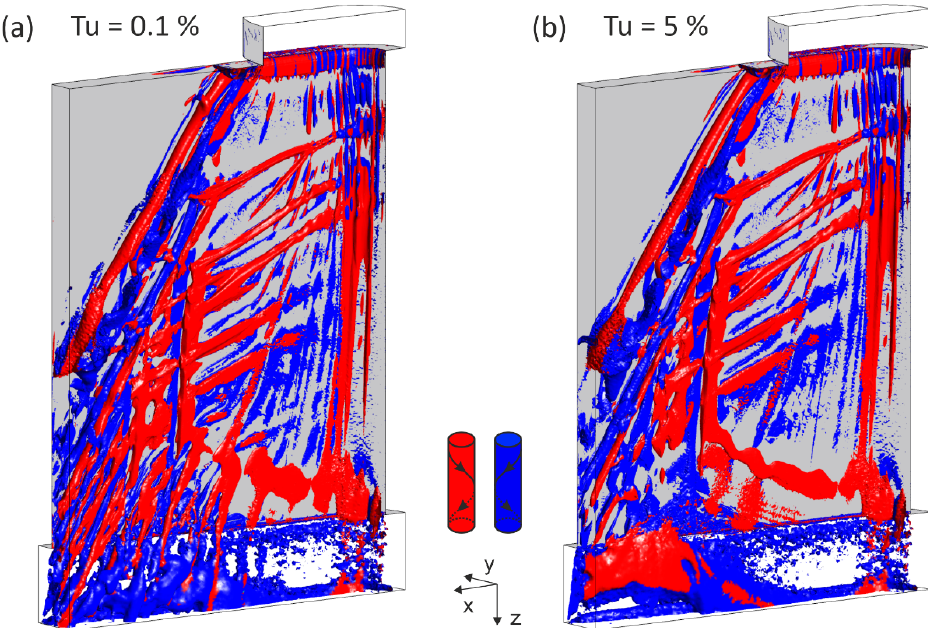
Figure A1. Vortex visualization by means of the isosurfaces of λ 2 criterion for λ 2 = − 4.89 × 10 9 s − 2 , colored by z-component of vorticity. Blue areas indicate right-handed and red left-handed vortex cores. ( a ) Tu = 0.1%, ( b ) Tu =